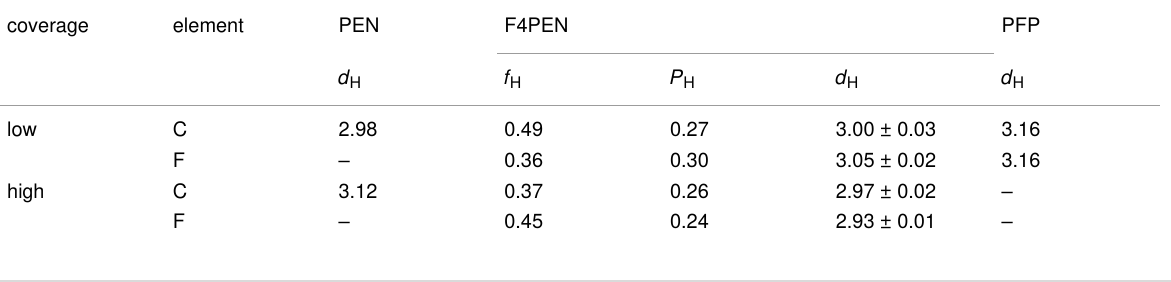
Table 1: Summary of the element-specific vertical adsorption heights ( d H /Å) of (fluorinated) pentacene in (sub)monolayers on Ag(111) measured with the XSW technique. A low coverage indicates the submonolayer (<2 Å) and a high coverage indicates an almost closed monolayer ( ≈ 3 Å). The values for PEN and PFP are taken from [51] and [50], respectively.